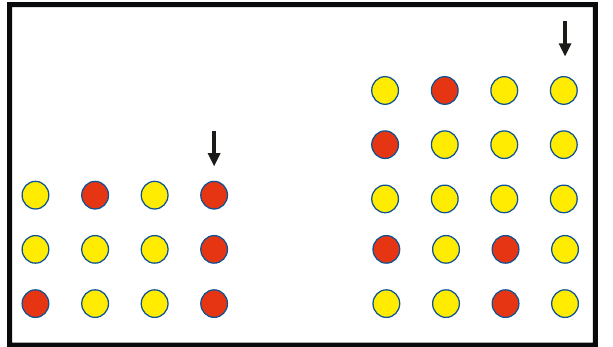
Figure 1: Pictorial representation of Fibonacci recursion